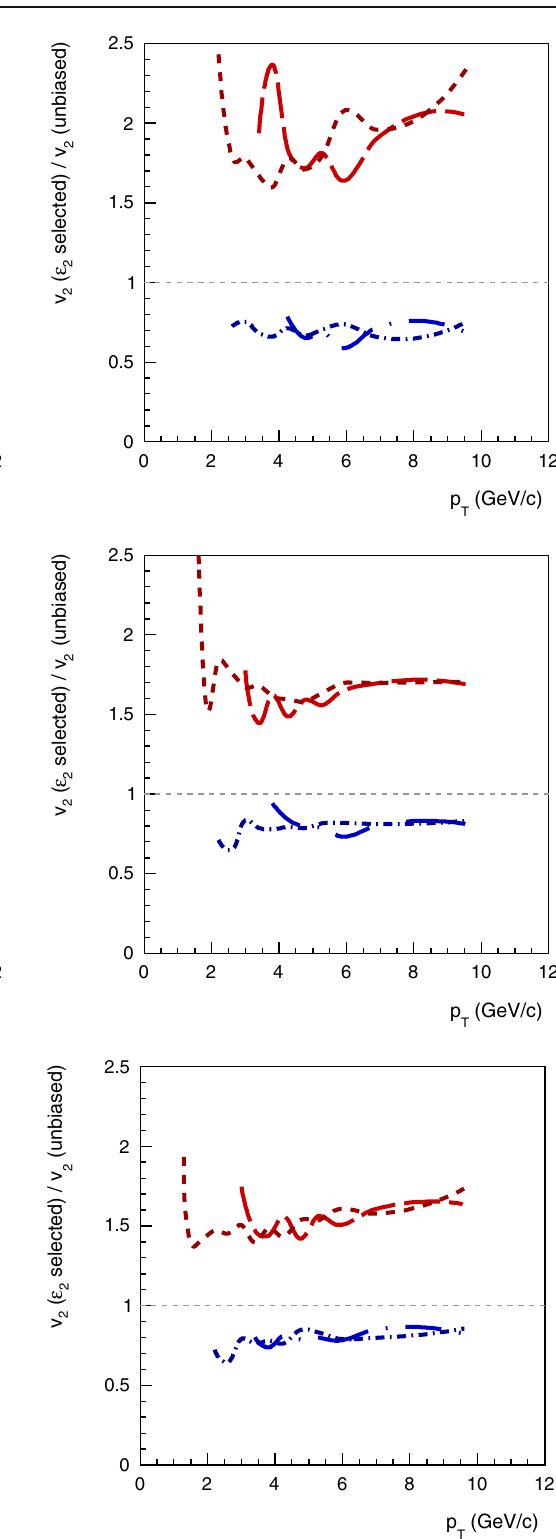
60% lowest- (cid:7) 2 selection of events are compared to the unbiased case. For both choices of transport coefficients the results display a strong and similar sensitivity to the initial